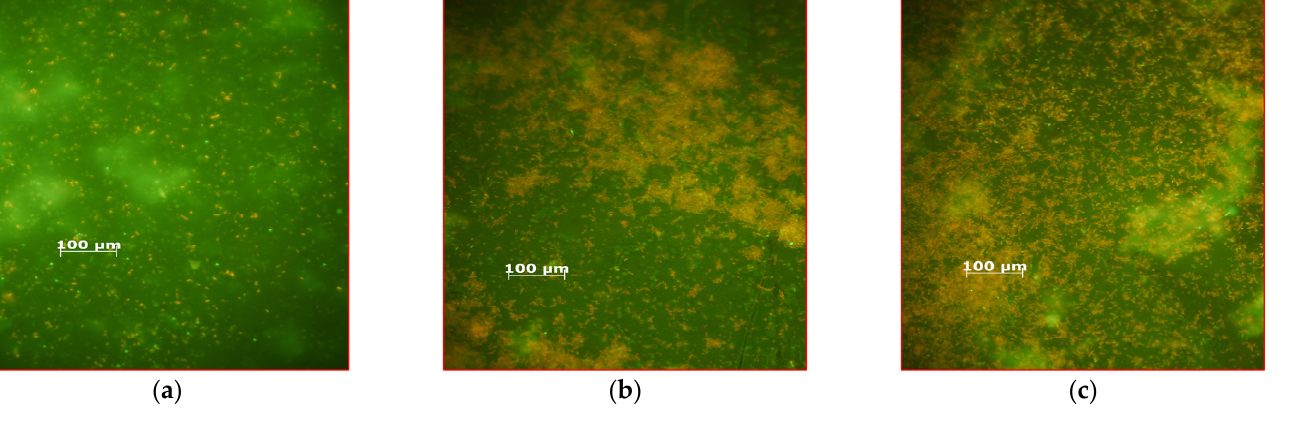
Figure 5. Fluorescence microscopy images of biofilm formed on the glass surface by S. aureus 3375 after the first ( a ); second ( b ) and third ( c ) exposures to laser light in the presence of MB alone at a nontoxic concentration of 31.25 mg L − 1 . In the presence of the SYTO 9 and propidium iodide mixture, bacteria with intact cell membranes stain fluorescent green, whereas bacteria with damaged membranes stain fluorescent red. Scale bar: 100 μ m.